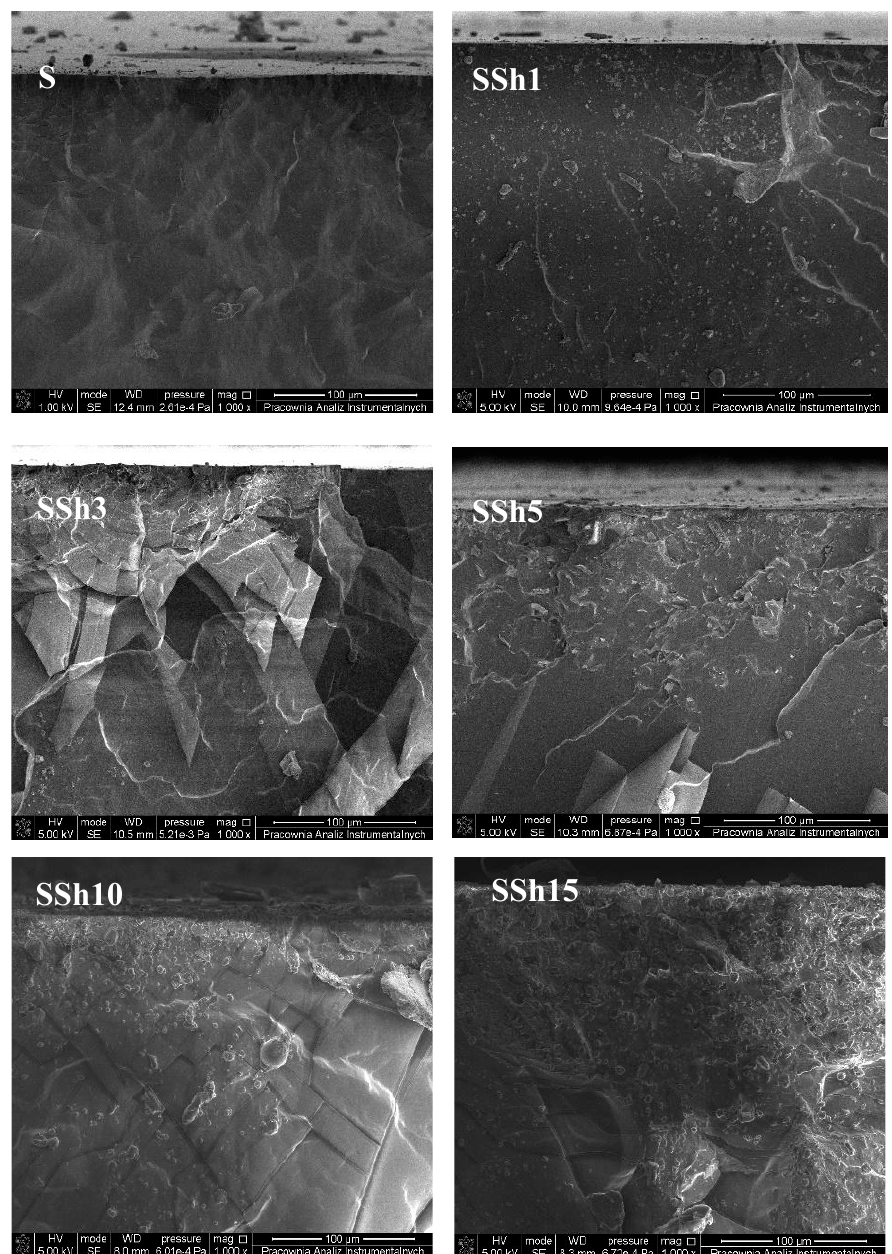
Figure 7. Cross sections of Sylgard and composites containing shungite.